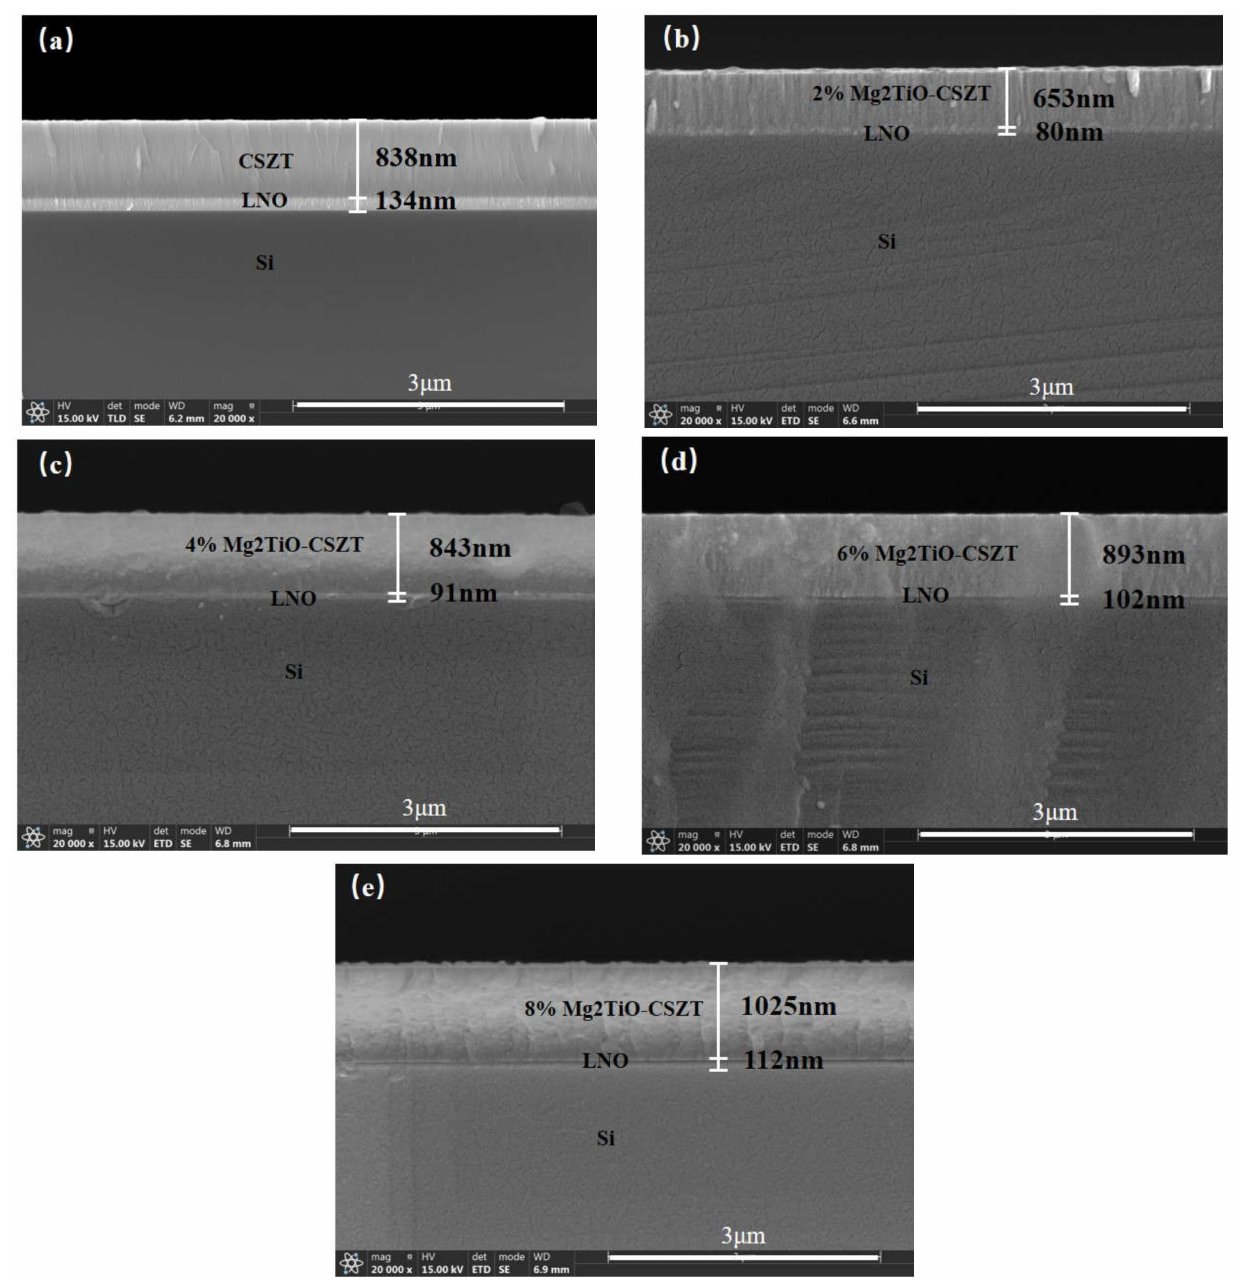
Figure 2. The cross-section scanning electron microscope (SEM) micrographs of the x%